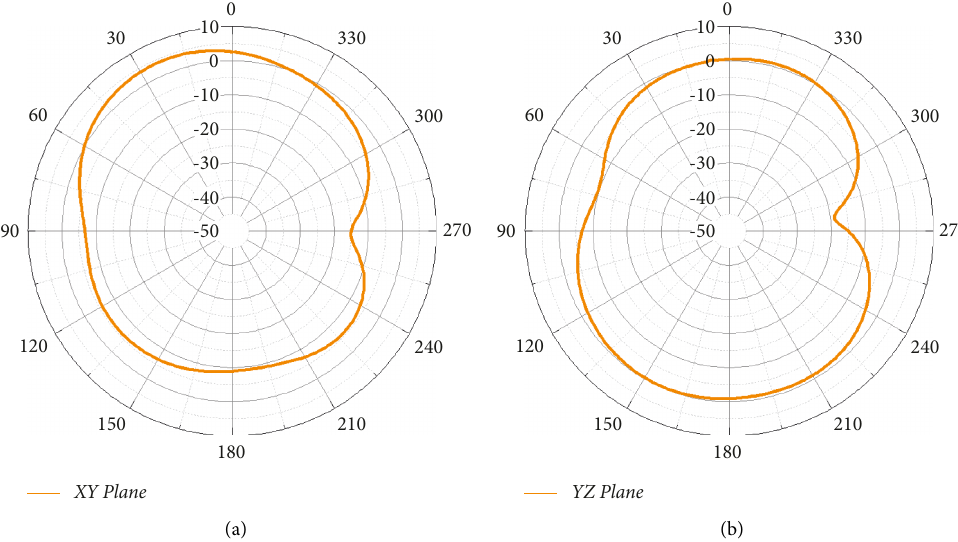
Figure 6: 2D radiation pattern in free space at 60GHz from (a) XY plane and (b) YZ plane.